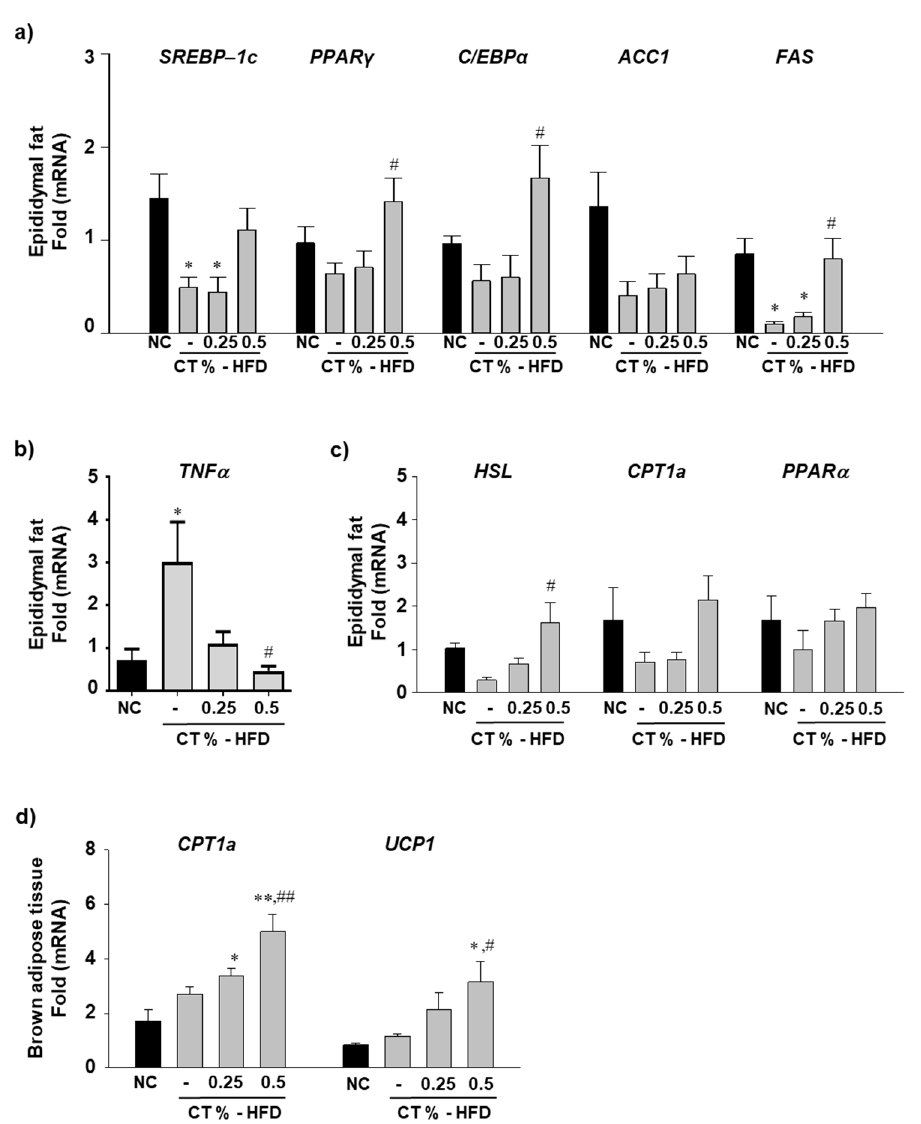
Figure 2. Effect of CT treatment on the metabolic gene expression levels in adipose tissues. One week after acclimatization, C57BL/6J mice were fed HFD mixed with 0.25% and 0.5% CT for 7 weeks. The mRNA expression levels of ( a ) sterol regulatory element-binding protein 1c (SREBP-1c), peroxisome proliferator-activated receptor gamma (PPAR γ ), CCAAT/enhancer-binding protein alpha (C/EBP α ), acetyl-CoA carboxylase-1 (ACC1) and fatty acid synthase (FAS) ( b ) tumor necrosis factor alpha (TNF α ) ( c ) hormone sensitive lipase (HSL), carnitine palmitoyltransferase 1a (CPT1a) and peroxisome proliferator-activated receptor alpha (PPAR α ) were measured in epididymal fat pads by quantitative real-time PCR (qRT-PCR). ( d ) The mRNA levels of CPT1a and uncoupling protein 1 (UCP-1) were analyzed with in brown adipose tissues by qRT-PCR. NC: normal chow; (-): HFD; CT-HFD; CT treated HFD. Values are mean ± SE. AVOVA p -value: ** <0.01, * <0.05 vs. NC group; ## <0.01, # <0.05 vs. HFD-fed group.